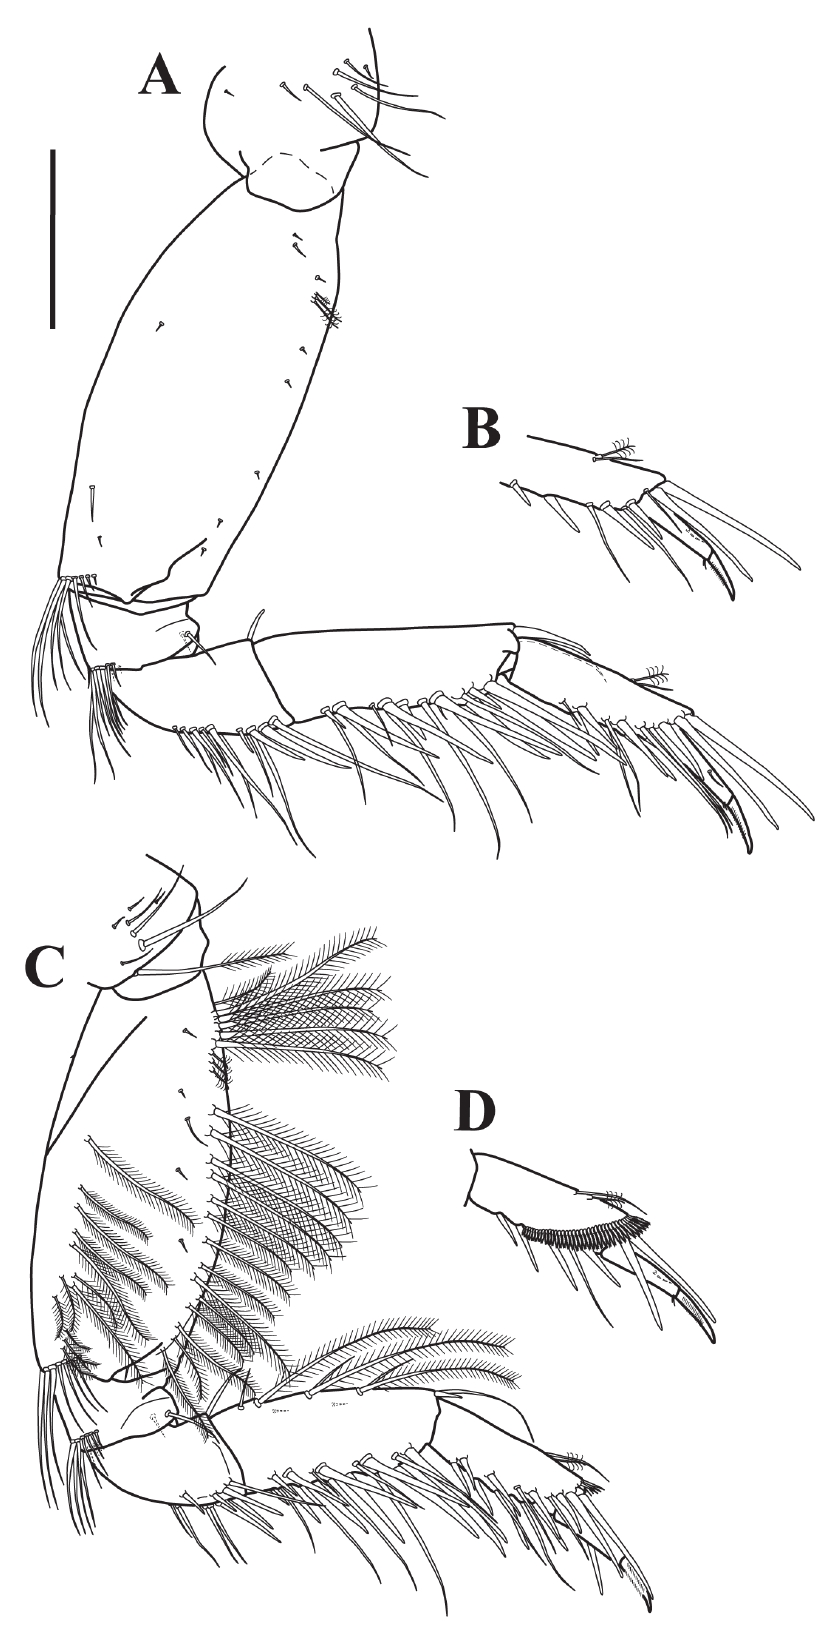
Figure 9. Brachylicoa lui sp. n. holotype female with oostegites and genital cone. A pereopod-5, lateral view; B propodus and dacty- lus of pereopod-5, inner view; C pereopod-6, lateral view; D propodus and dactylus of pereopod-6, inner view. Scale bar = 0.5